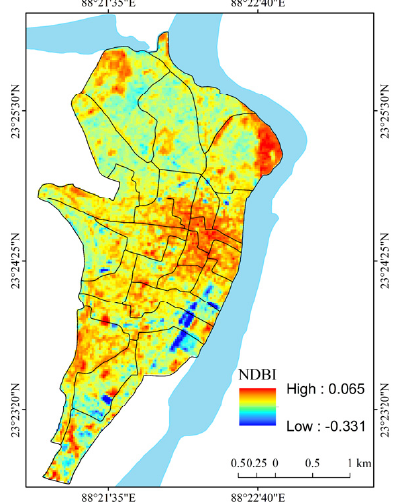
Figure 38. NDBI (2015).